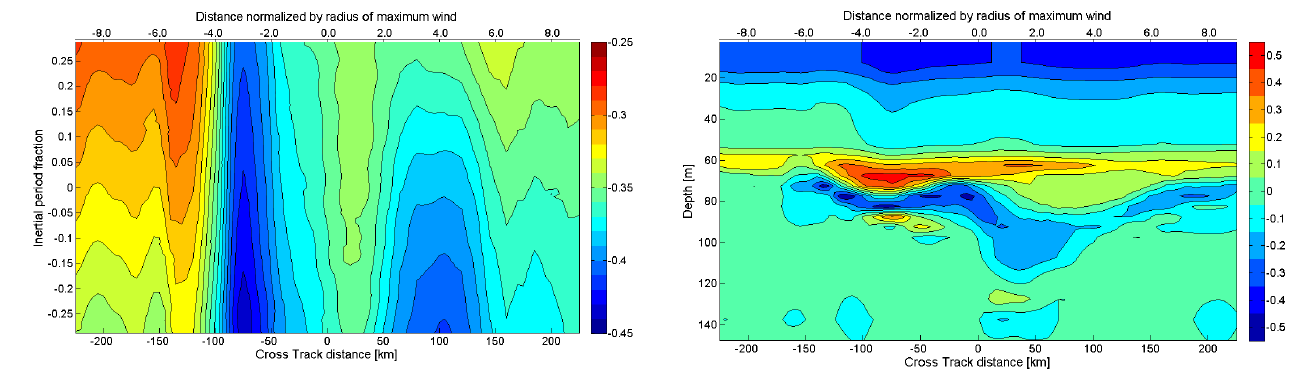
Figure 13. Vertical section of the double-TC temperature anomaly (see Eq. 1) averaged over an inertial period (40h). The lower x axis Fig. 13. Vertical section of the double-TC temperature anomaly (see EQ. 1)averaged over an 3 represents distance from the Jangmi track in kilometers; the upper x axis is the same distance normalized by radius of maximum wind, inertial period (40h). The lower x-axis represents distance from the Jangmi track in km; the 4 which is 25km in this case; the ordinate represents ocean depth in upper x-axis is the same distance normalized by radius of maximum wind which is 25 km in 5 meters. The 0 position is at the typhoon center. Color scale repre- sents temperature anomaly [ ◦ this case; the ordinate represents ocean depth in m. The 0 position is at the typhoon center. 6 Color scale represents temperature anomaly [C]. 7